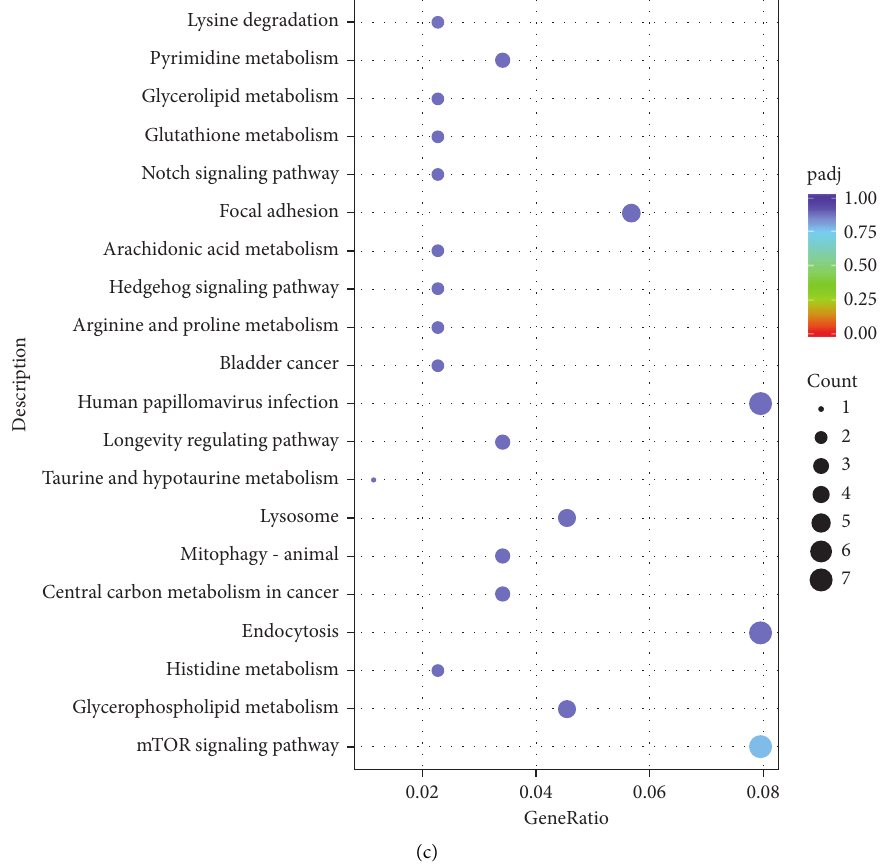
Figure 2: Profiles of differentially expressed gene transcripts between control patients without obstructive sleep apnea (non-OSA; apnea- hypopnea index (AHI) ≤ 5 without hypertension) and patients with OSA and hypertension (OSA-HTN; AHI ≥ 30). (a) Hierarchical heat maps, (b) volcano plots, and (c) top 20 overrepresented Kyoto Encyclopedia of Genes and Genomes pathways of the common differentially expressed genes. The colors (red, orange, green, light blue, and purple) represent the Q value (i.e., the lowest false discovery rate), whereas the variably sized dots represent the number of genes involved in each pathway. Table 3: Top 10 differentially expressed mRNAs in severe-OSA with HTN patients compared with non-OSA without hypertension subjects. Upregulated mRNAs Downregulated